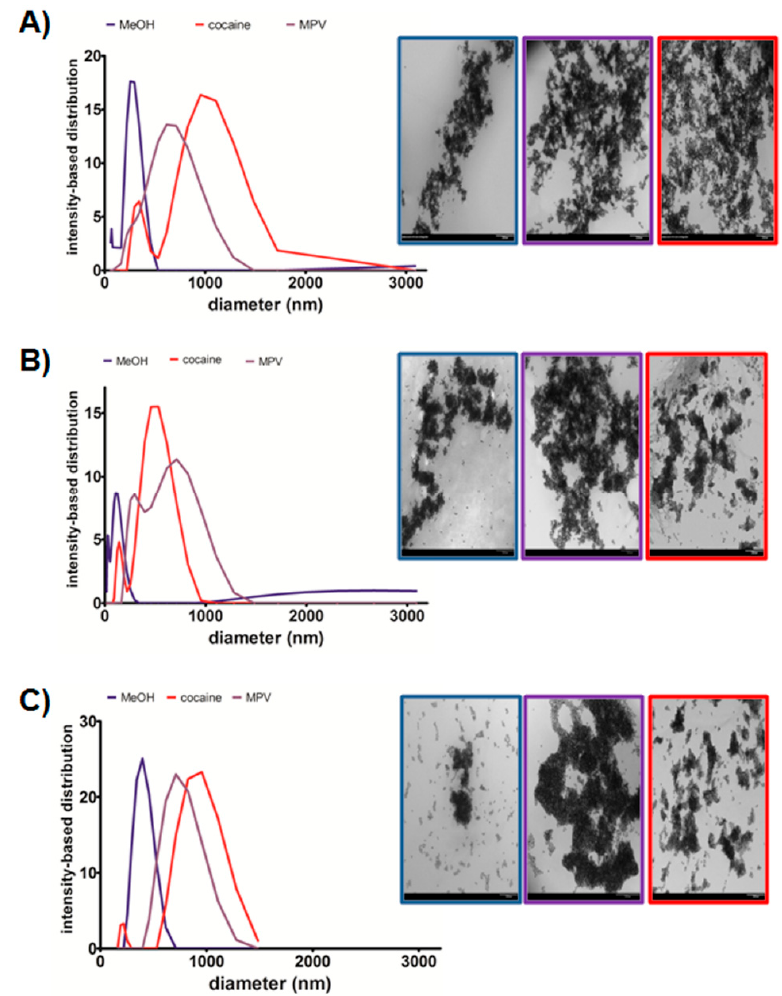
Figure 4. DLS and TEM characterization. Left: Apt-AuNP size distribution as determined by DLS after NaCl addition, Right: color-coded TEM images after NaCl addition of: ( A ) c-AuNPs, ( B ) MN4-AuNPs, and ( C ) EBA-AuNPs, after exposure to methanol (blue trace), cocaine (red trace) and MDPV (purple trace). Scale bar, 200 nm.